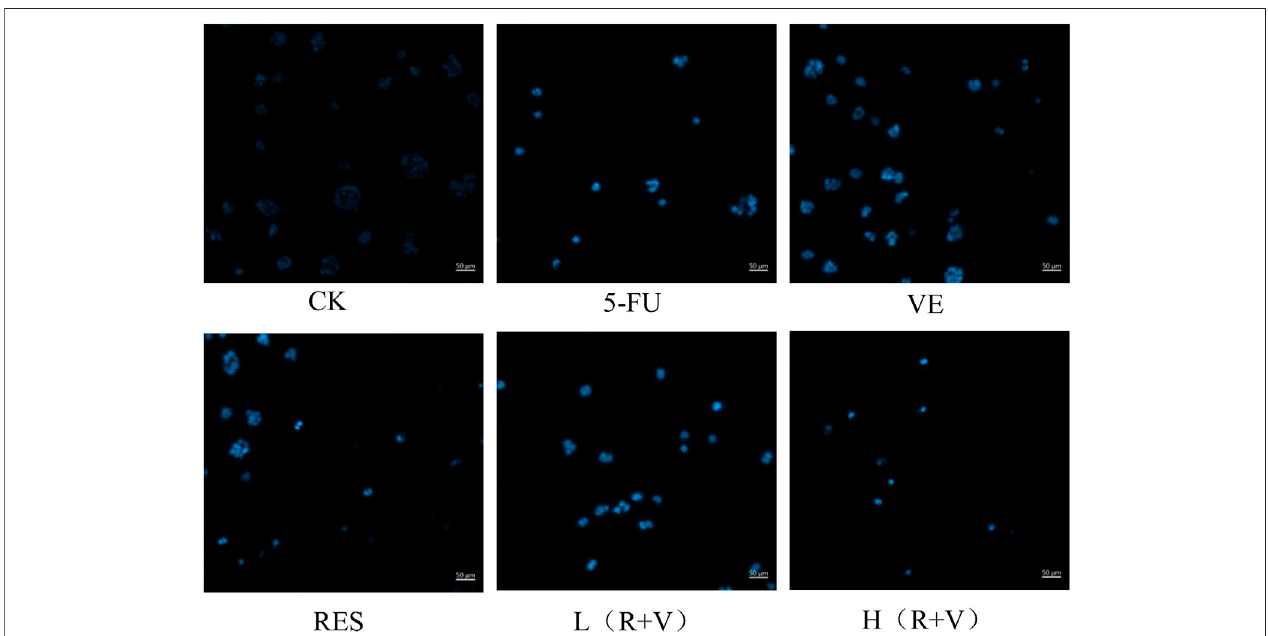
FIGURE 6 | Morphological changes of HCT-8 cell nuclei under an inverted fl uorescence microscope after 36 h of treatment with different drugs.